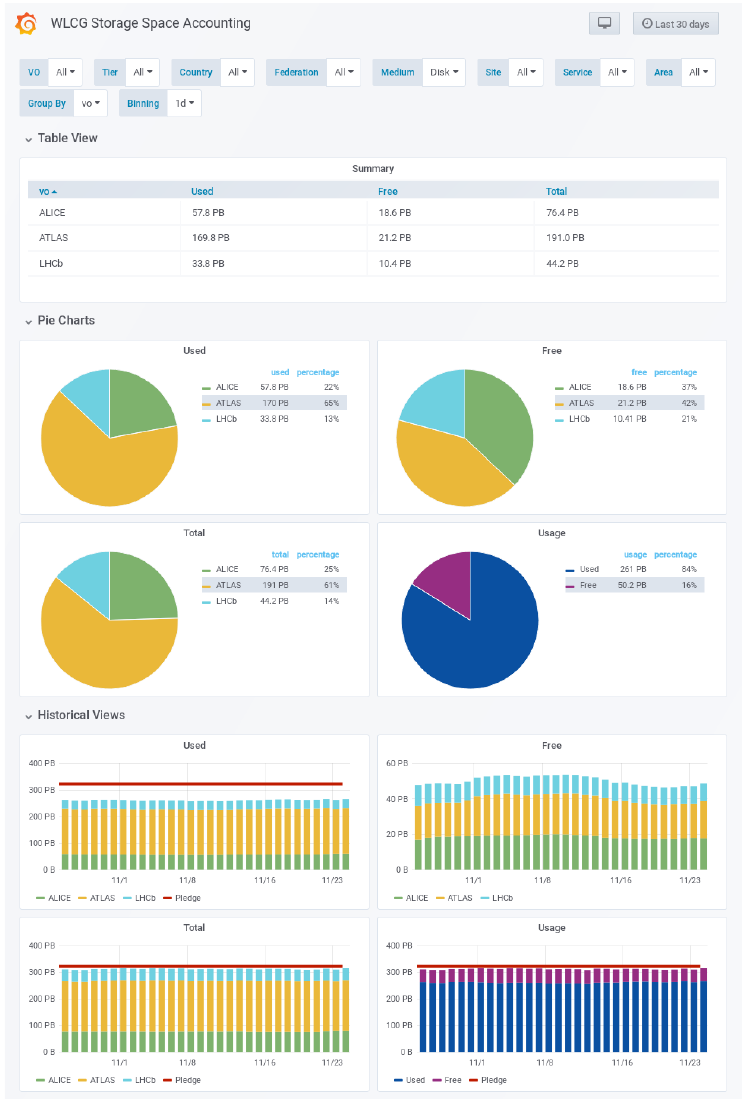
Figure 3. The WSSA dashboard o ff ers filters for fine-tuning and presents the information in multiple